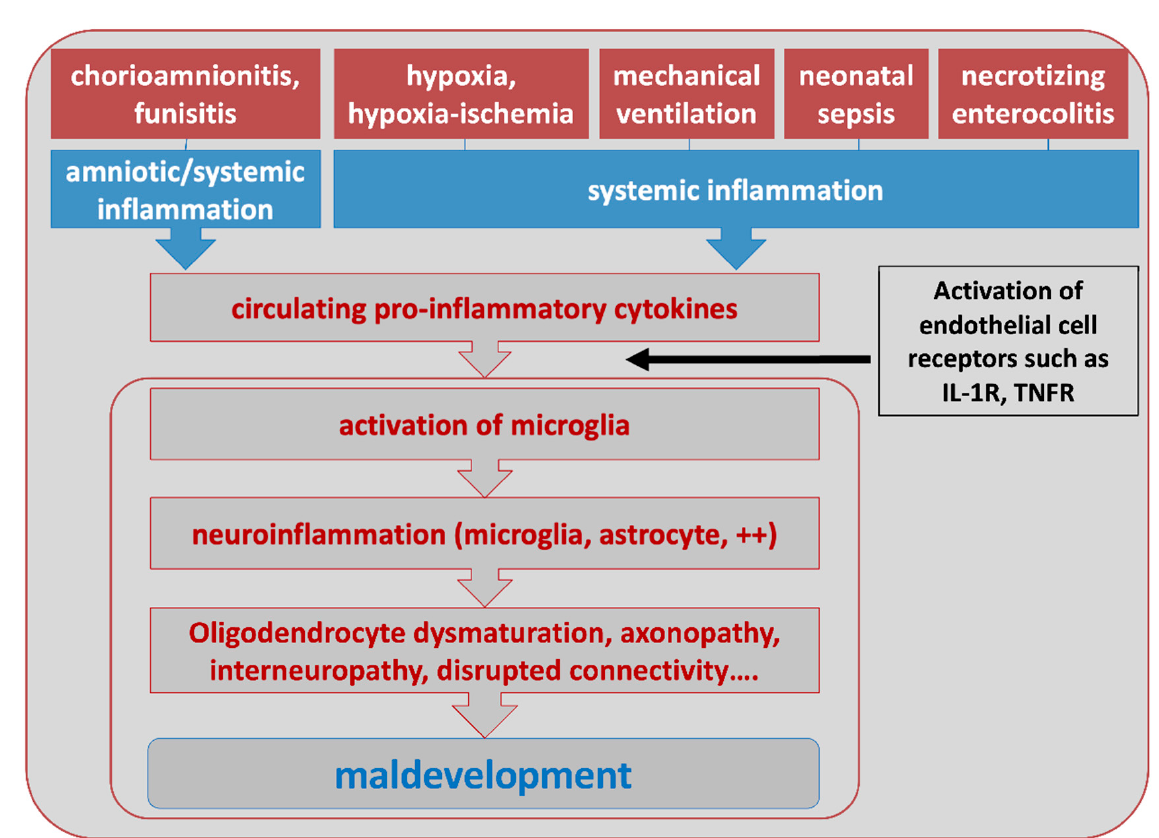
Figure 2. Potential sources of systemic inflammation reported in PBIs and a basic outline of the steps to brain maldevelopment, including from [71–73] and others in this review.